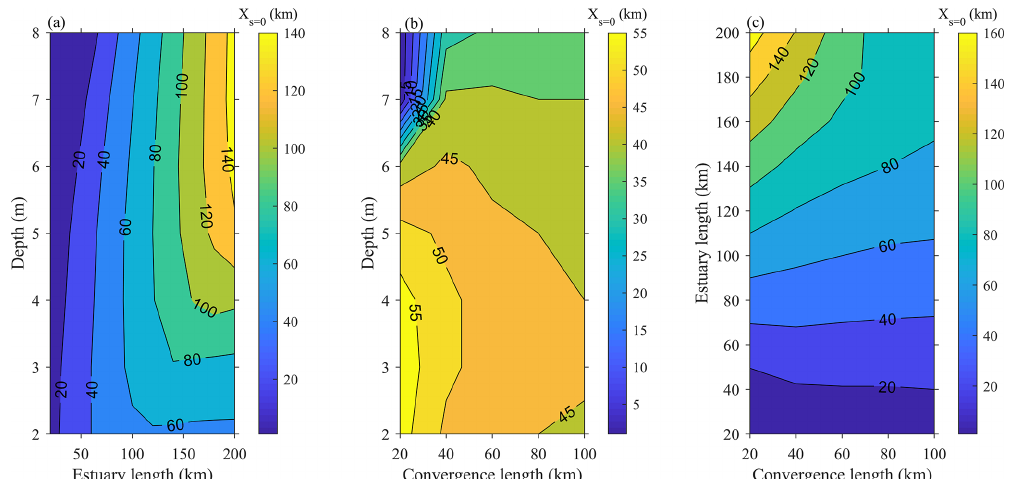
Figure 11. Position of the negligible slope ( X S = 0; in kilometres) along a semi-closed channel with distinct geometric settings. In panel (a) , the convergence length is 38km. In panel (b) , the estuary length is 78km. In panel (c) , the water depth is